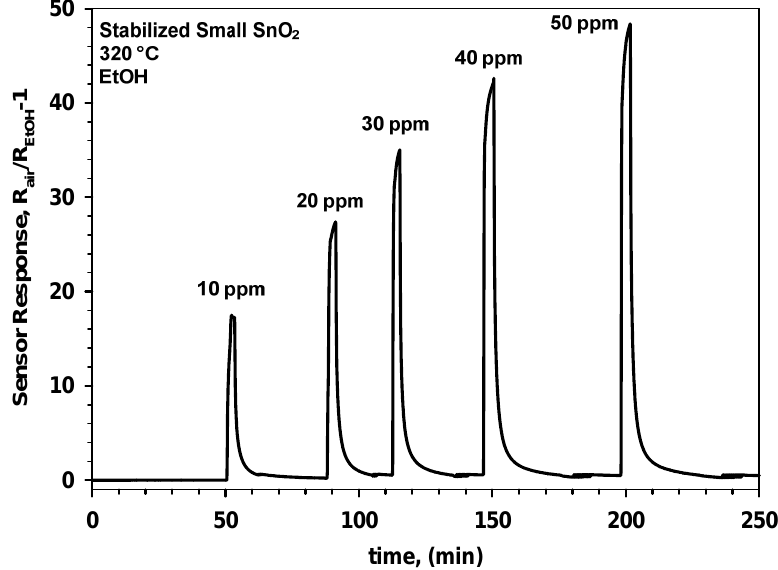
Figure 6. Response of a gas sensor made of small SnO sintering step at 600